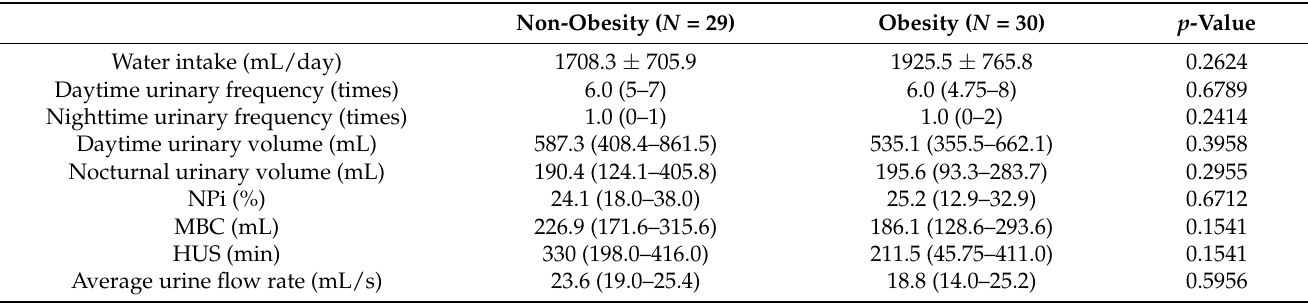
Table 3. Voiding parameters measured by 24 h voided volume monitoring system of participants grouped by obese status.